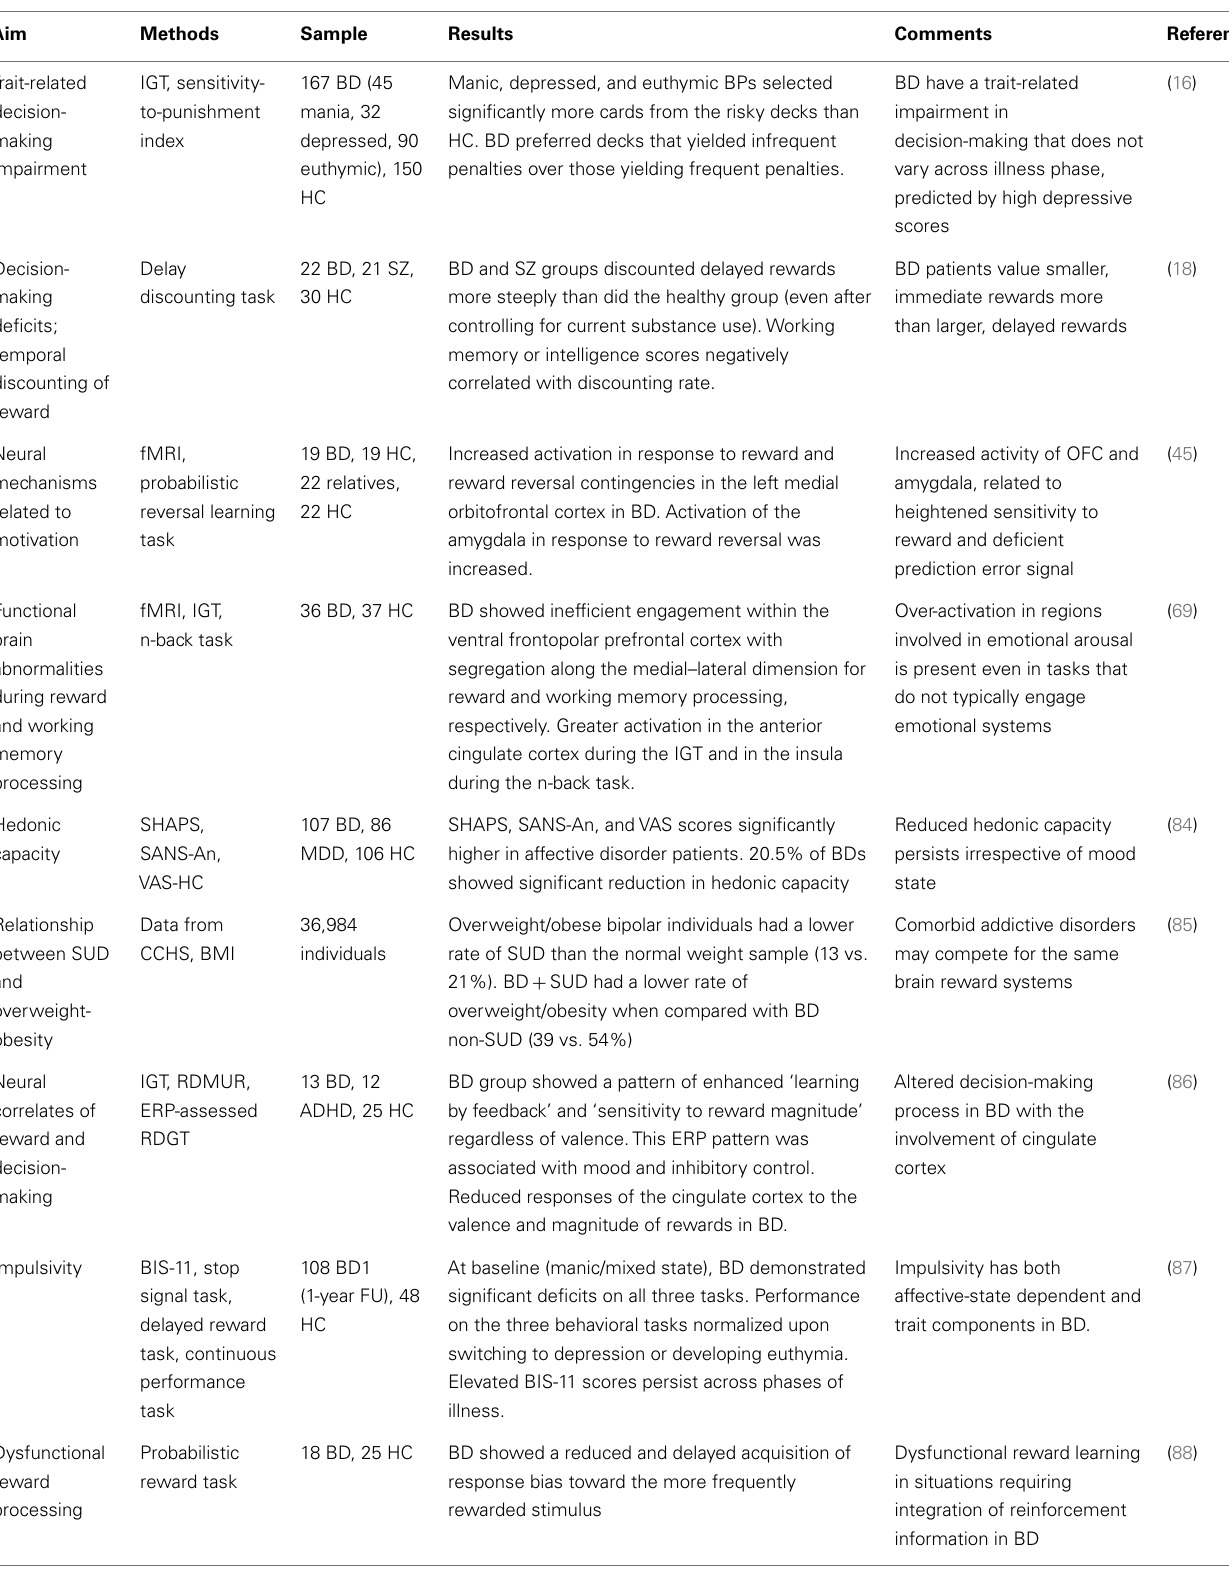
Table 1 | Reward-system alterations and vulnerability to addiction in euthymic bipolar patients